Question: What kind of plot is shown here?
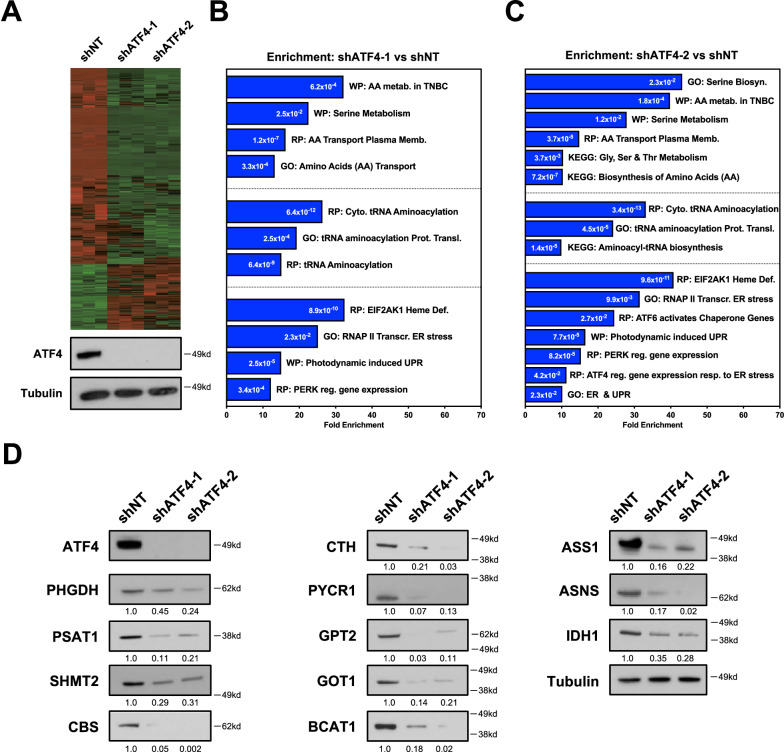
Answer: heatmap